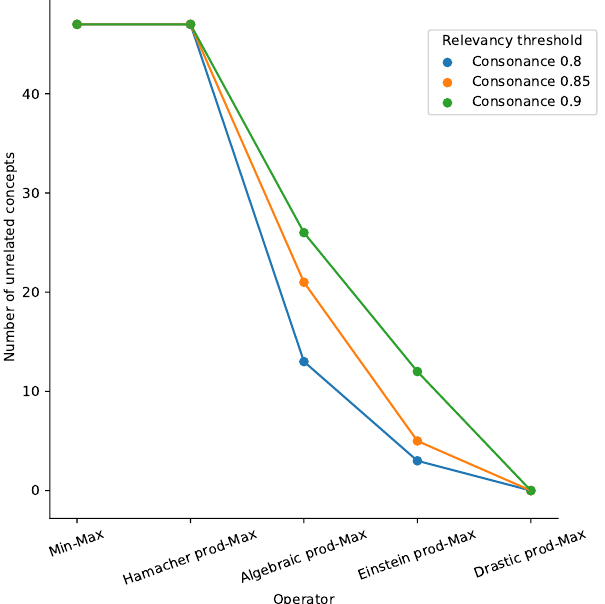
Figure 4. Number of unrelated concepts for the retail FCM when using different composition operators and relevancy